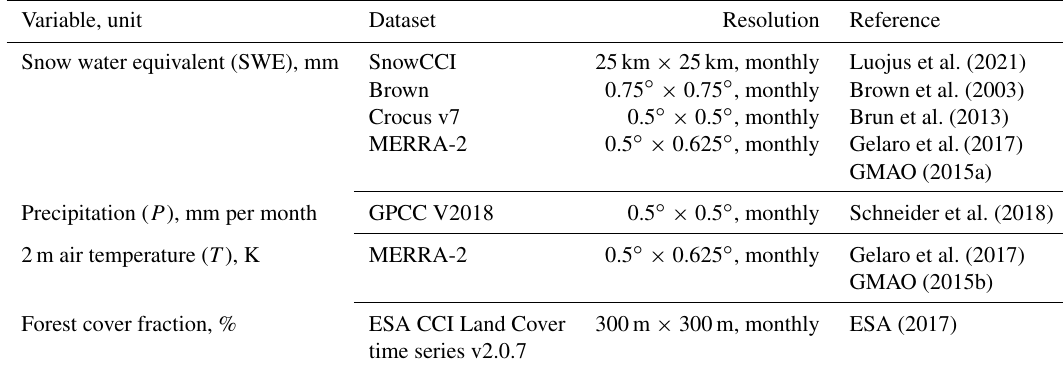
Table 2. Observational and reanalysis datasets used in this study. Variable,